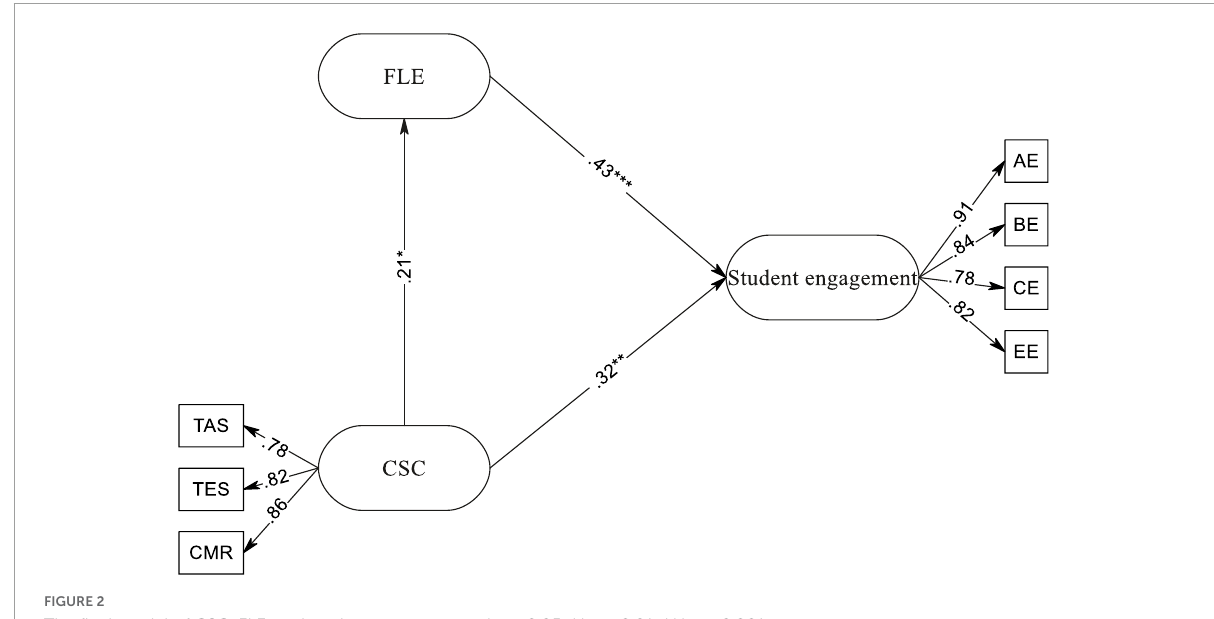
FIGURE2 The final model of CSC, FLE, and student engagement. * p < 0.05, ** p < 0.01, *** p < 0.001.